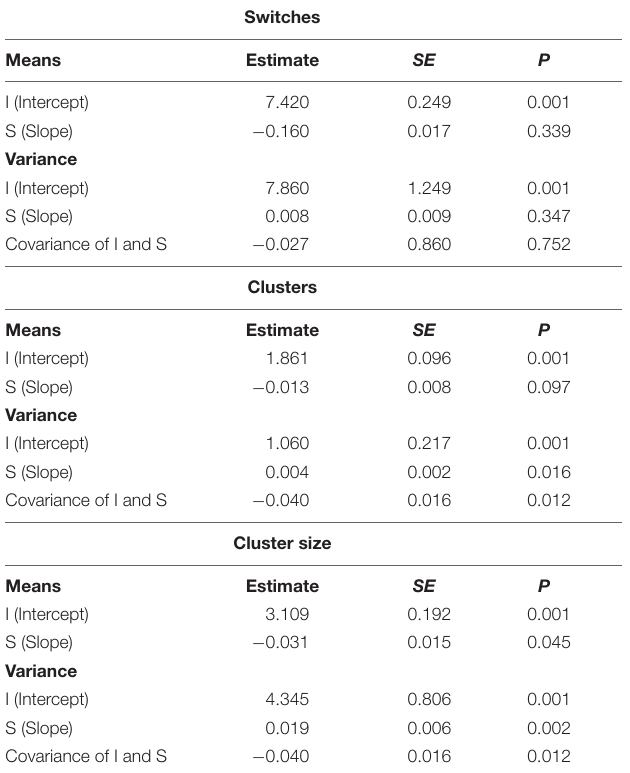
between participants. Of the three covariates bilingualism was significantly associated ( β = 0.646, SE = 0.319, p = 0.043) with the intercept. That is, on average, a bilingual participant had